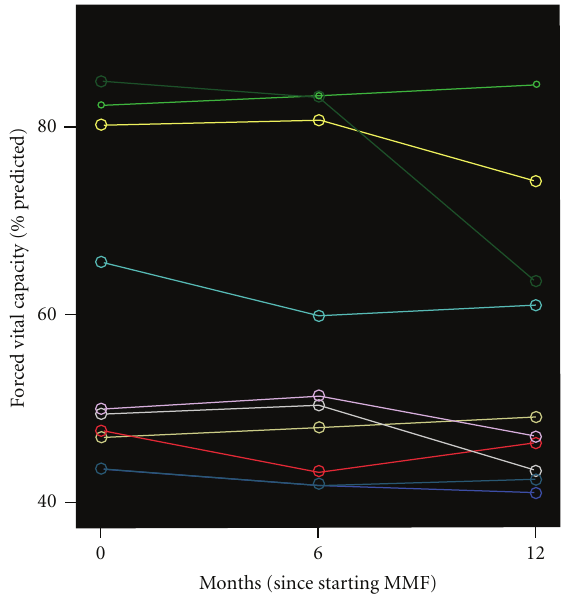
Figure 1: Forced vital capacity (FVC) fluctuations over time for each subject. Each line represents measurements made in a single subject. A time point 0 month indicates when MMF treatment was